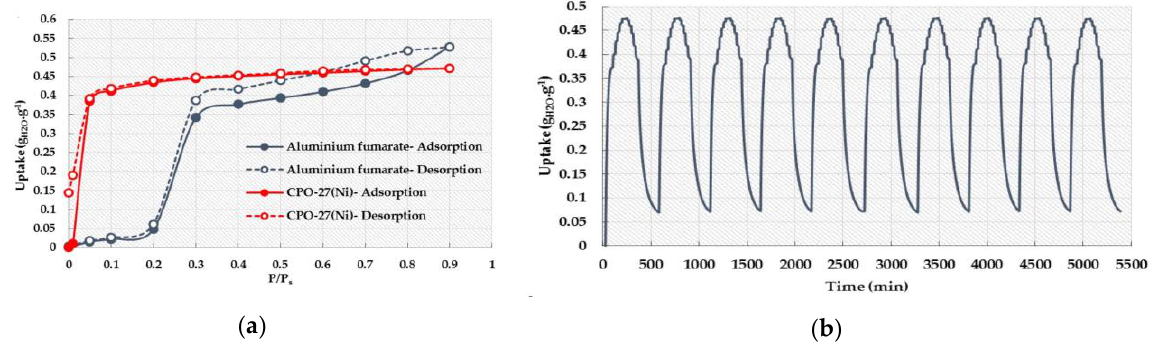
Figure 8. ( a ) Water adsorption isotherms of CPO-27(Ni) at 298 K and ( b ) Adsorption/desorption cycling experiments for CPO-27(Ni). Reproduced with permission from [72]. Elsevier, 2016.